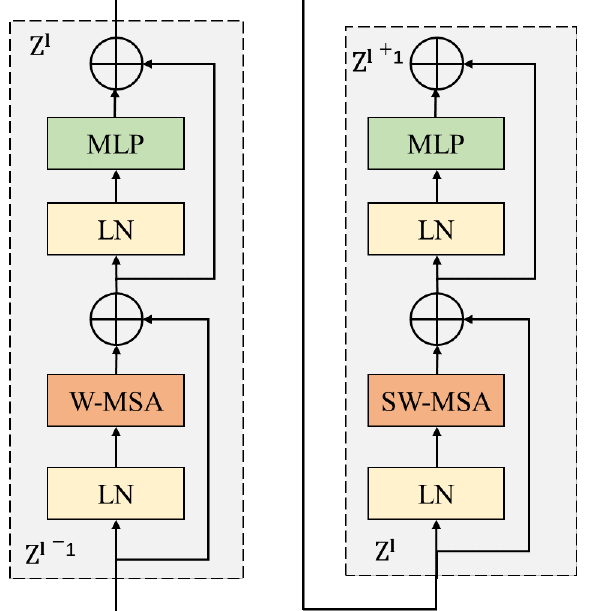
Figure 6. Two successive Swin Transformer